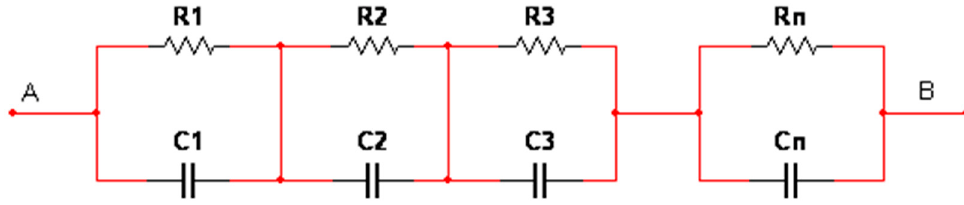
Figure 11. Equivalent circuit of fractional integral operator 1 (cid:2869)